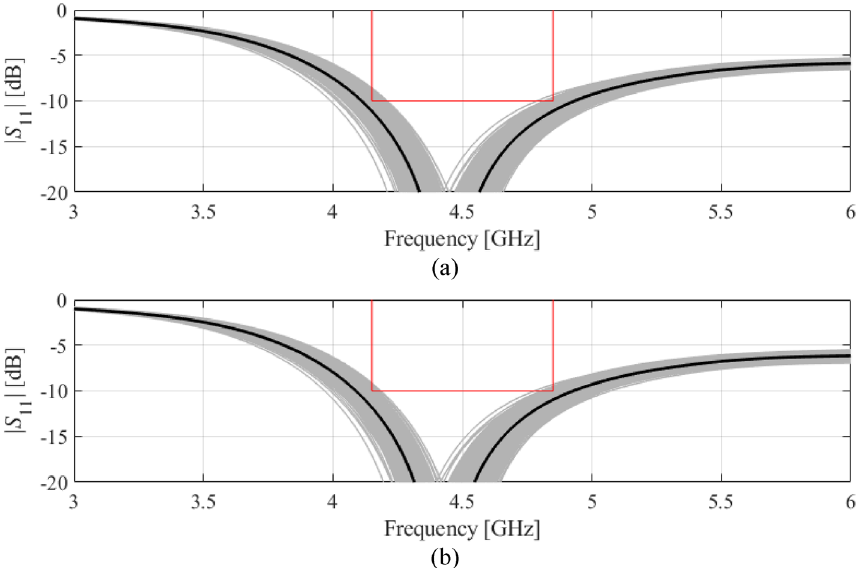
Figure 4. Visualization of EM-driven Monte Carlo simulation of Antenna I using 500 samples. Gray plots represent random observables, whereas the black plot is the antenna response at the center design (nominal for ( a ) and yield-optimized for ( b )). Target operating bandwidth and reflection level has been marked using vertical and horizonal lines, respectively: ( a ) nominal design, ( b ) robust design.